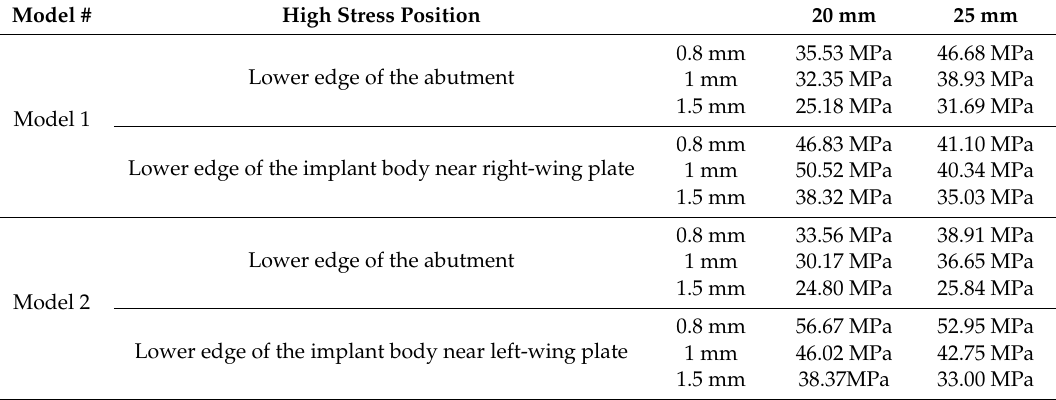
Table 2. High-stress values at di ff erent points on the implant body.